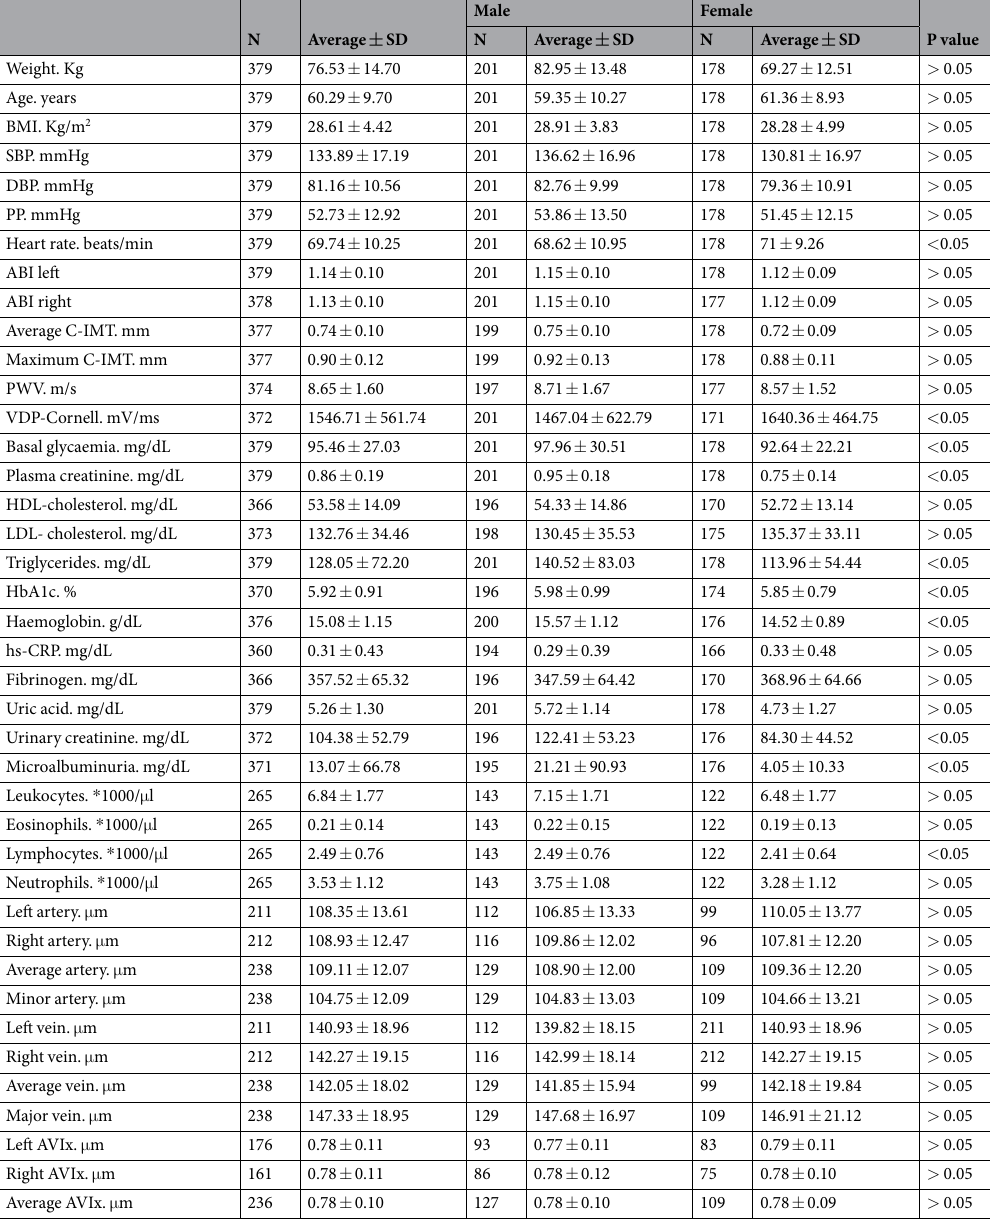
Table 3. Demographic, physical and basic analytical values of the patients included in the study. ABI: ankle brachial index; AVIx: arteriovenous index; BMI: body mass index; C- IMT: carotid intima media thickness; DBP: diastolic blood pressure; HbA1c: glycosylated hemoglobin; HDL: high-density lipoprotein; hs-CRP: high sensitive C-reactive protein; LDL: low-density lipoprotein; PP: pulse pressure; PWV: pulse wave velocity; SBP: systolic blood pressure; SD: standard deviation; VDP: voltage duration product. Artery, vein and AVIx values are retinal